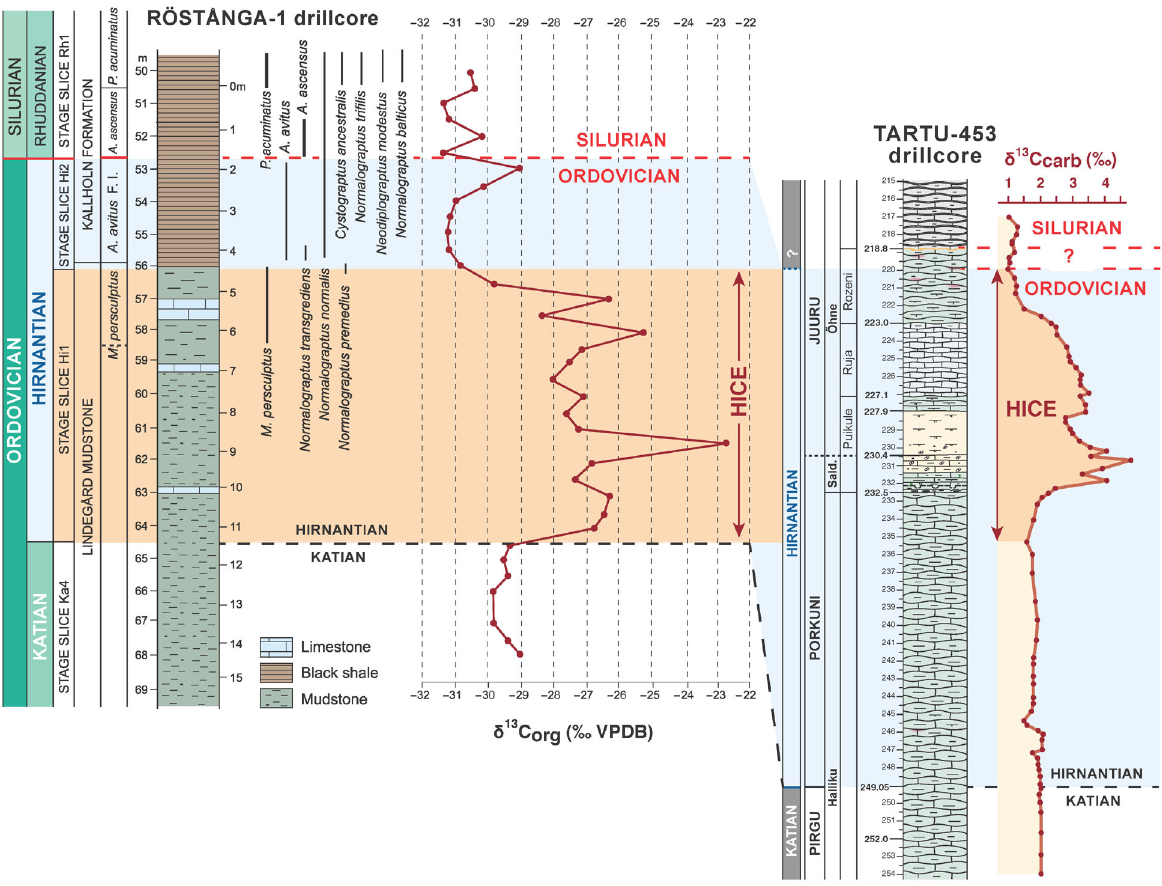
Fig. 2. Comparison of the HICE and the Hirnantian Stage in the Tartu-453 drillcore with coeval strata in the R(cid:246)st(cid:229)nga R-1 drillcore (modified from Bergstr(cid:246)m et al. 2014), which shows ranges of stratigraphically important graptolites. Figures along the left side of the drillcore log indicate drillcore depth and along the right side (cid:150) a stratigraphical